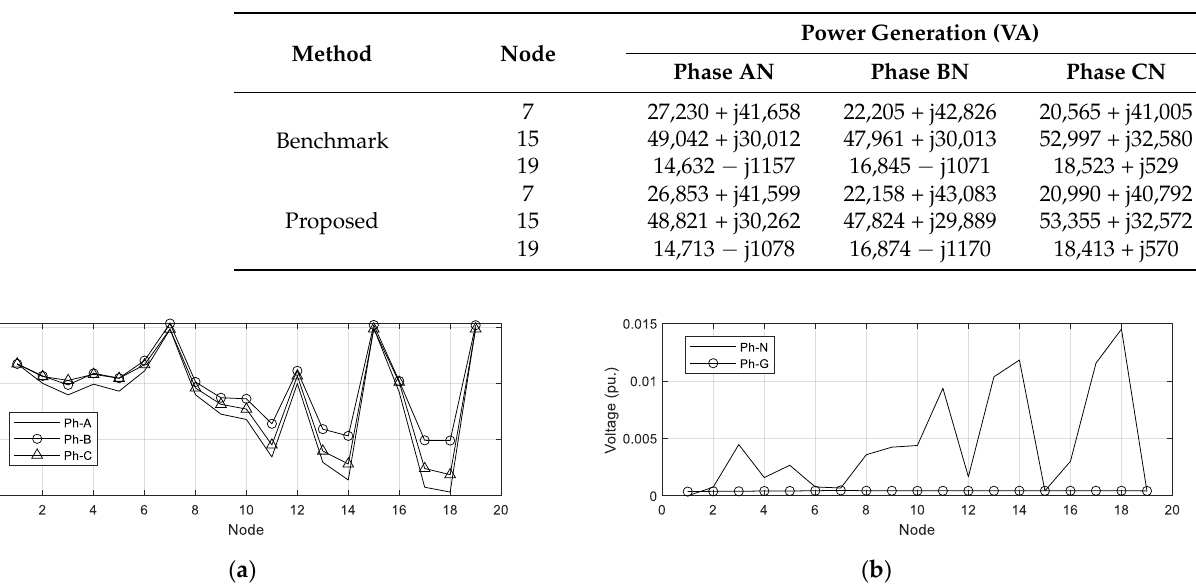
Table 7. Power generation at PV nodes of benchmark and proposed methods.